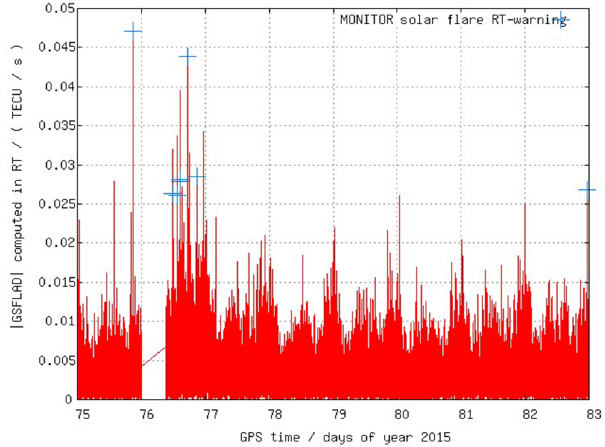
Figure 18. Absolute value of GSFLAI index as it was computed in real time on days 75–82, 2015. The blue crosses indicate the solar flare warnings provided by the UPC system in real time).